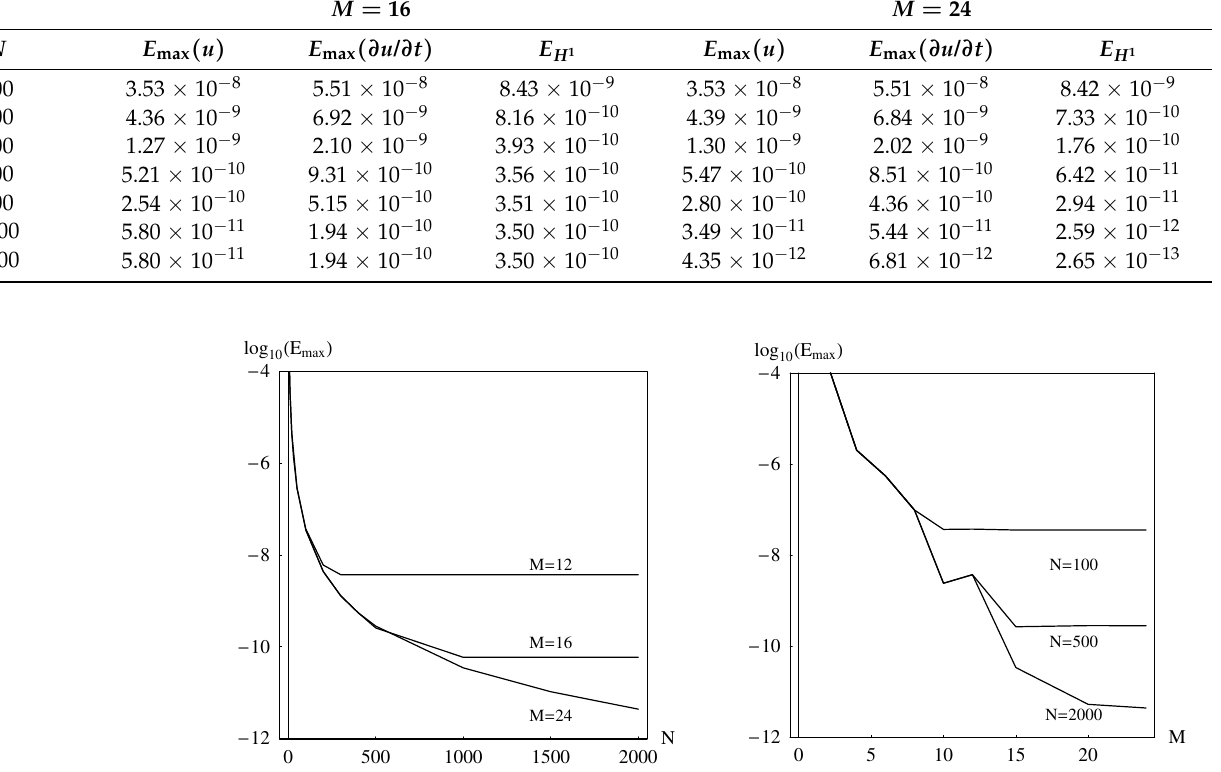
Table 4. The MAE of the u and ∂ u / ∂ t versus N using M = 16 (left) and 24 (right). M = 16